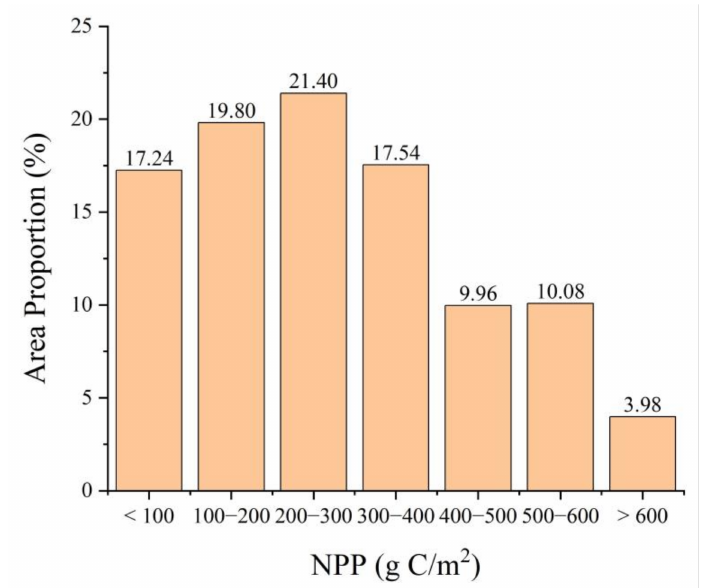
Figure 5. Spatial distribution of the average NPP in the Inner Mongolia grassland during 2000–2020.